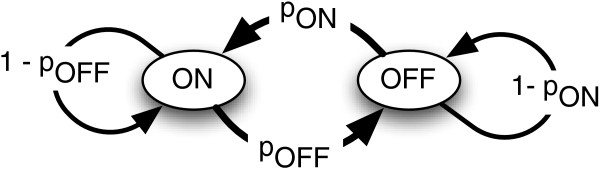
The state transition diagram for a single cell. The arrows between the ON and OFF states represent the probabilities of transition between the states per unit time.